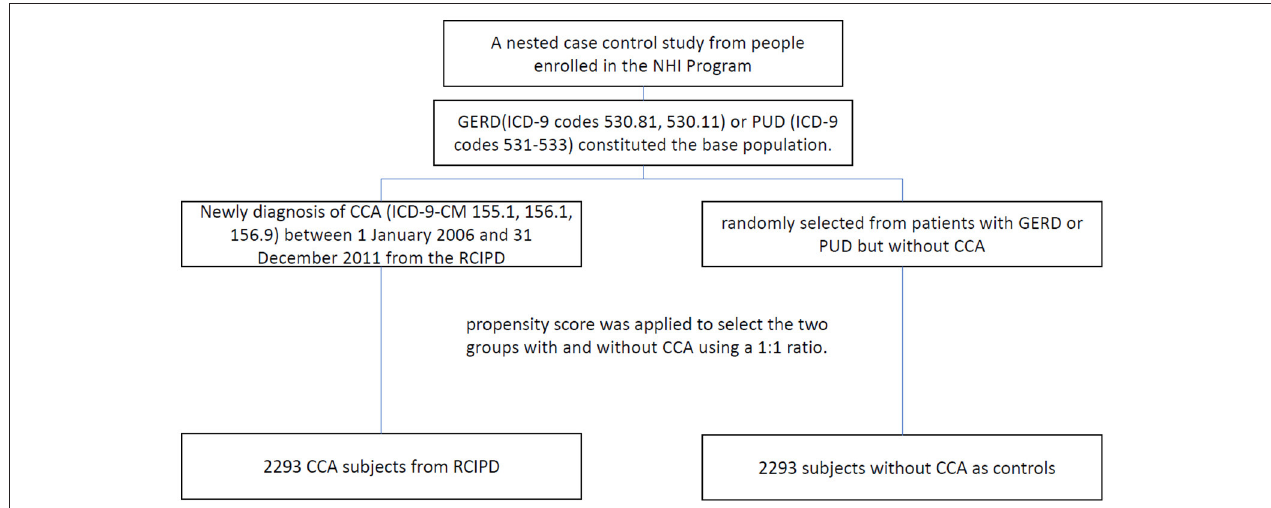
FIGURE 1 | Study flow diagram (NHI, national health insurance; RCIPD, Registry of Catastrophic Illness Database; GERD, gastroesophageal reflux disease; PUD, peptic ulcer disease; CCA, cholangiocarcinoma.